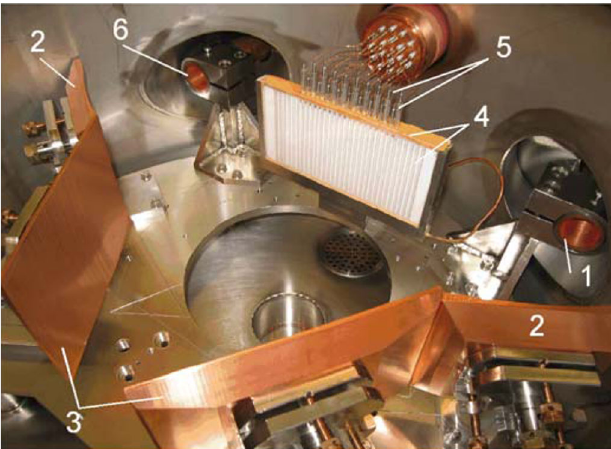
FIG. 6. (Color) The three-mirror resonator arrangement for the QO compressor with a diffraction grating: 1—input horn, 2— focusing mirrors provide the coupling from the Gaussian mode launchers to the resonator through the secondary lobe of the grating, 3—resonator mirrors, 4—active diffraction grating, 5— electrodes, 6—output